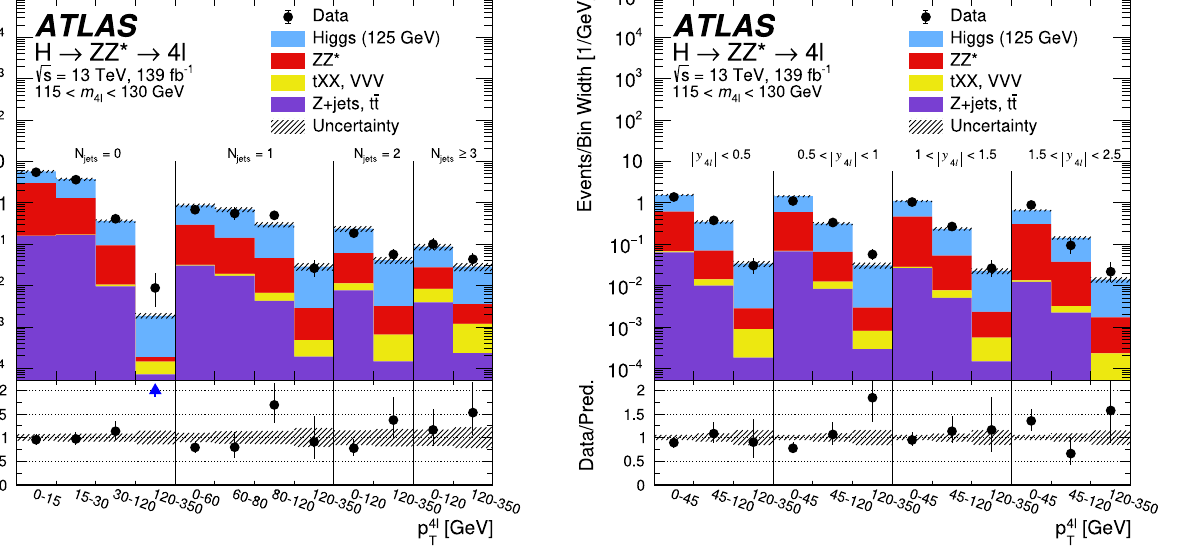
in T < 130 GeV, for an integrated √ 4 (cid:3) s = 13 TeV. A SM Higgs boson